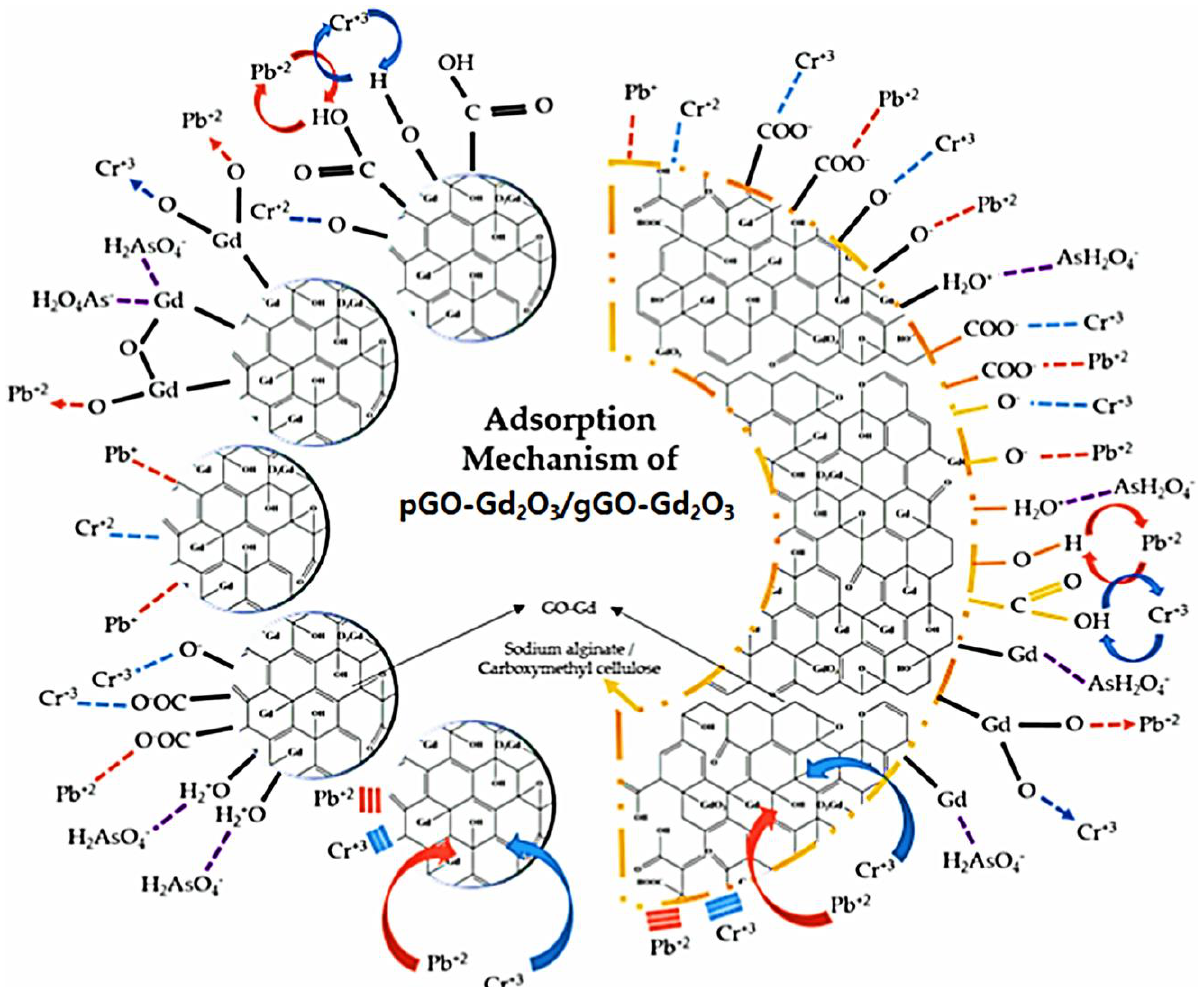
Figure 9. Proposed adsorption mechanism of Cr(III), Pb(II), and As(V) on gGO-Gd 2 O 3 [83]. (Adapted with permission from ref. [83]. Copyright 2022 Elsevier.)